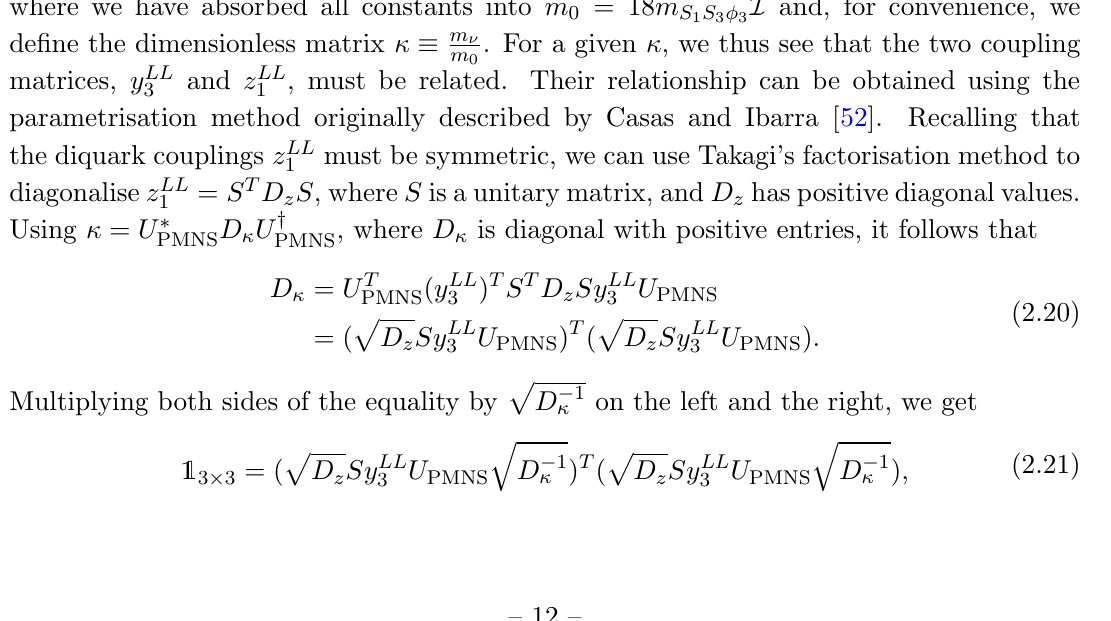
JHEP03(2020)150